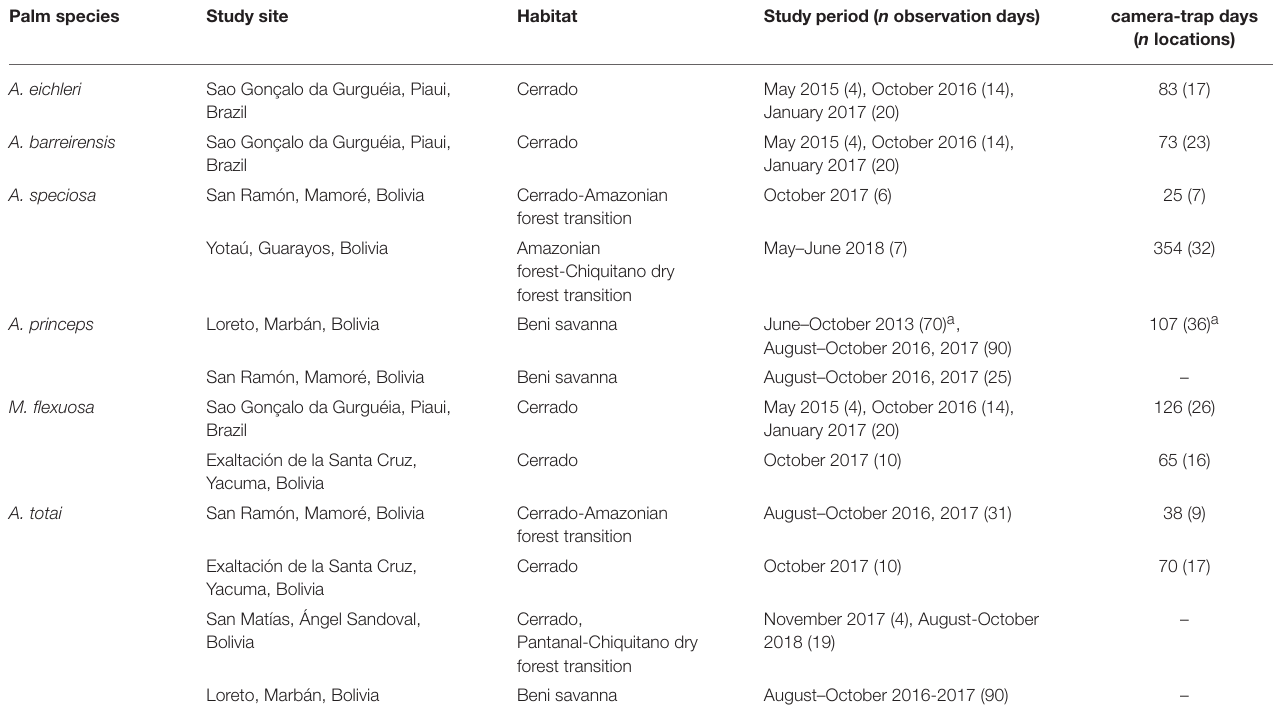
TABLE 1 | Location, habitat, study periods, and sampling effort (number of days of observation, number of camera-trap days, and number of camera locations) for each palm species in each study area. Palm species